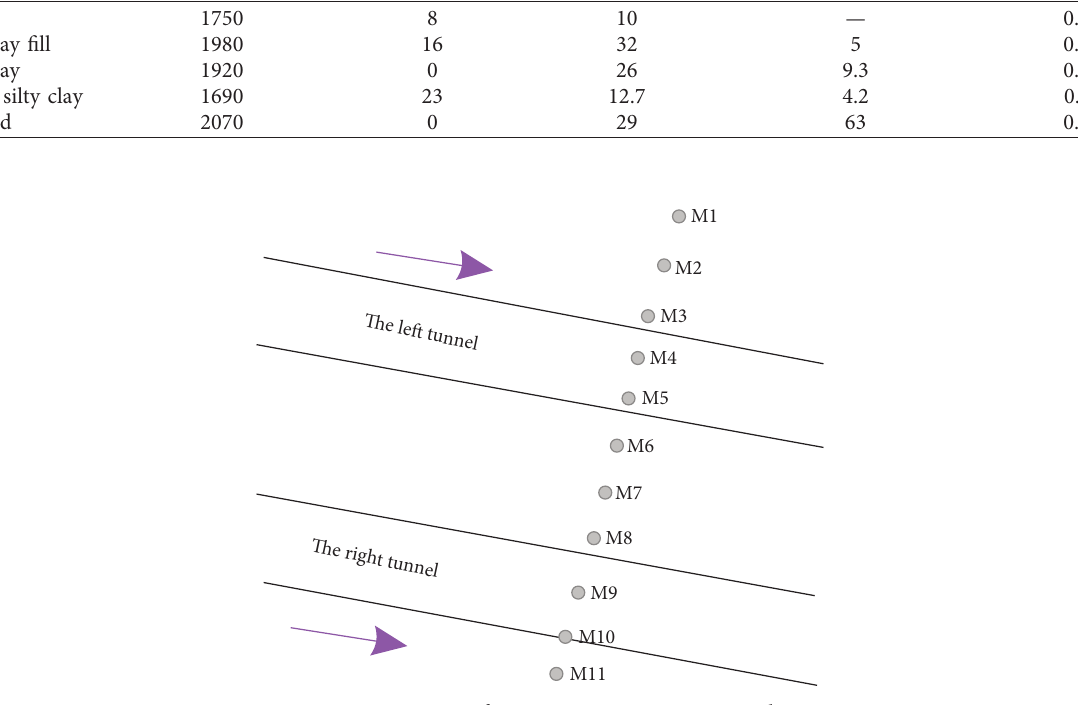
Figure 11: Layout of measurement points in